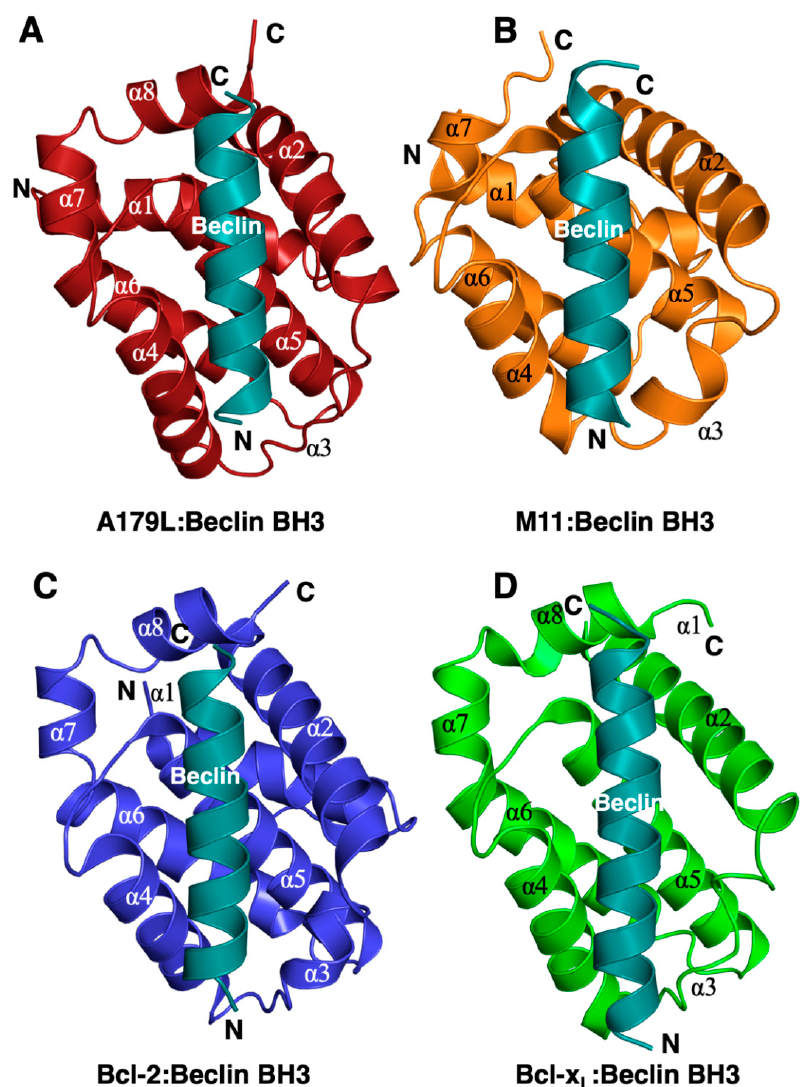
Figure 2. Comparison of the structure of A179L:Beclin BH3 with other Beclin BH3 complexes of Bcl-2 proteins. Ribbon representation of ( A ) A179L (firebrick) in complex with the swine Beclin BH3 motif (cyan). A179L helices are labeled α 1-8. The view in (A) shows the hydrophobic binding groove formed by helices α 2-5. ( B ) γ -herpesvirus 68 M11 (orange) in complex with the human Beclin BH3 motif (cyan) (PDB ID:3BL2). ( C ) Human Bcl-2 (blue) in complex with the human Beclin BH3 motif (cyan) (PDB ID:5VAU). ( D ) Human Bcl-x L (green) in complex with human Beclin BH3 motif (cyan) (PDB ID:2P1L). All views in ( B – D ) are as in ( A ). The orientation of the ribbons is identical to Figure 1B and